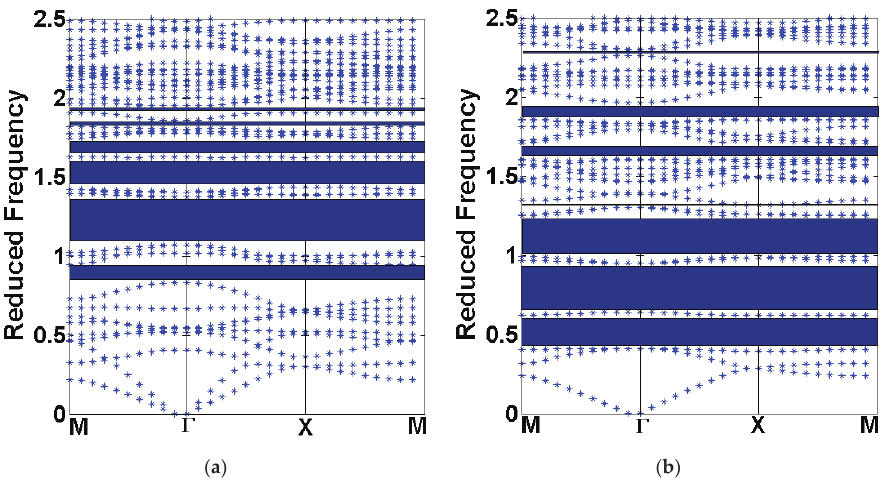
Figure 2. Dispersion diagrams of the MPnC with circular scatterers and Kagomé lattice, considering XY modes ( a ) and Z modes without piezoelectricity and piezomagnetism ( b ) for f = 0.5. The shaded regions are the complete Bragg-type band gaps. Crystals 2020 , 10 , x